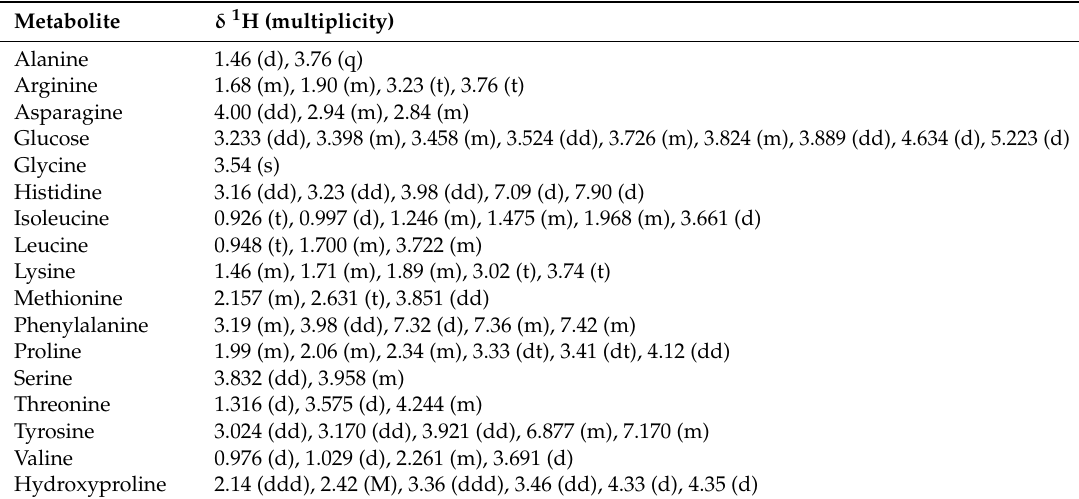
Table 2. List of identified metabolites and their chemical shift ( δ